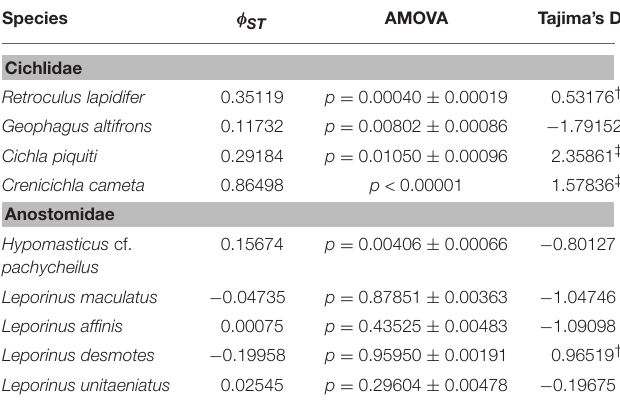
TABLE 3 | Analysis of population differentiation among rapids of the Araguaia River, and demography of each species.